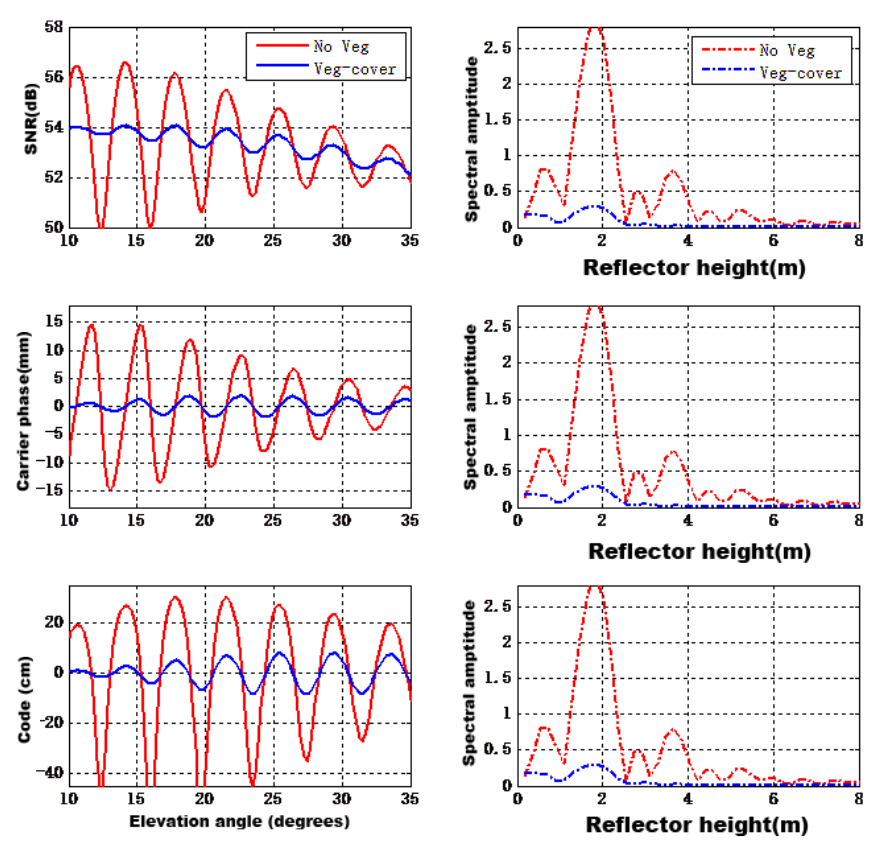
Figure 12. Changes in multipath observation and effective reflectometer height corresponding to vegetation